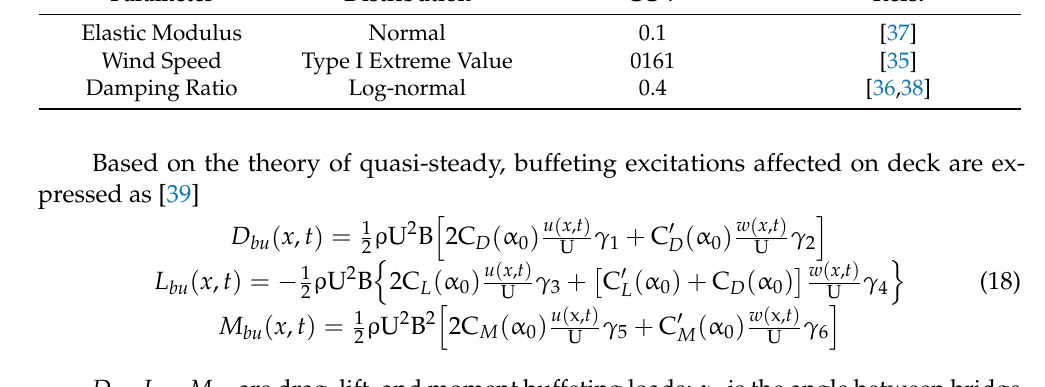
Table 2. Bridge structural natural frequencies and mode features.